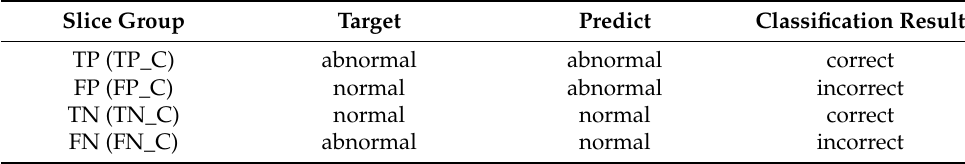
Table 5. The confusion matrix for the AH